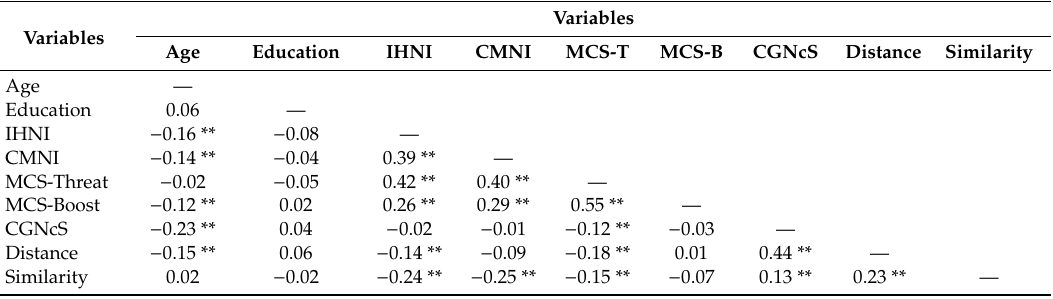
Table 3. Bivariate correlations between demographic and various factors.